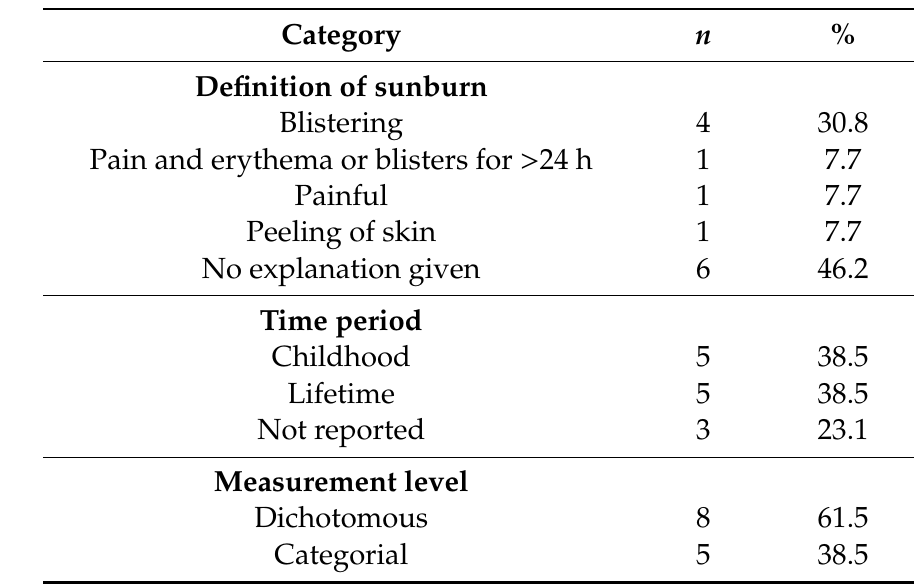
Table 3. Heterogeneity of the risk factor sunburns in risk prediction models for melanoma regarding three aspects: definition of sunburn, time period of sunburn occurrence and measurement level ( n = 13 models).